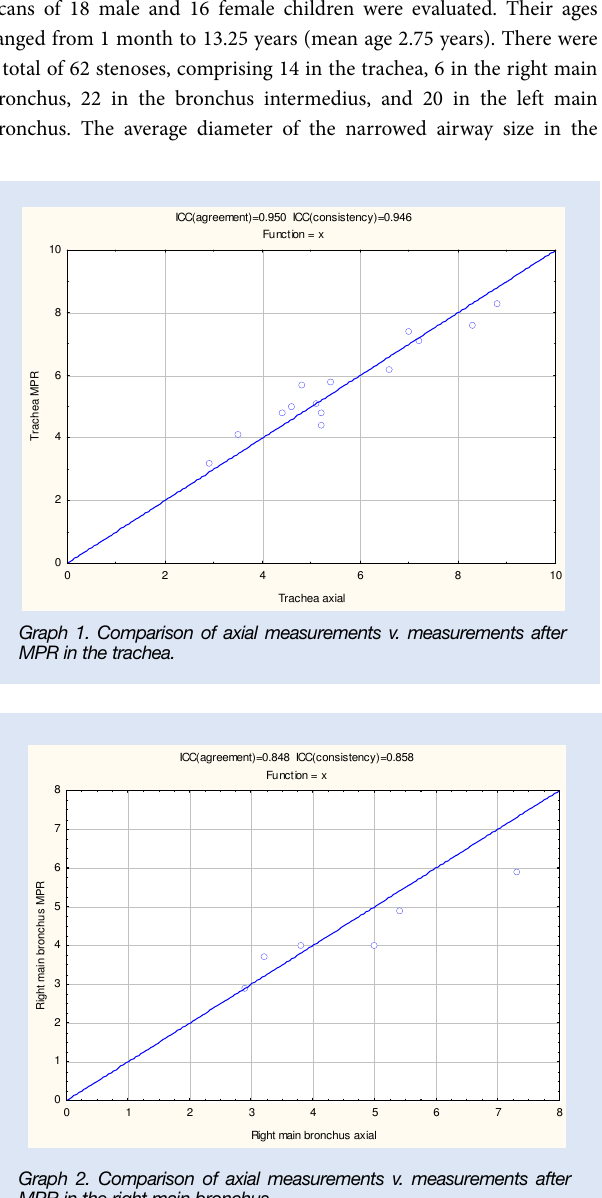
Graph 1. Comparison of axial measurements v. measurements after MPR in the trachea 